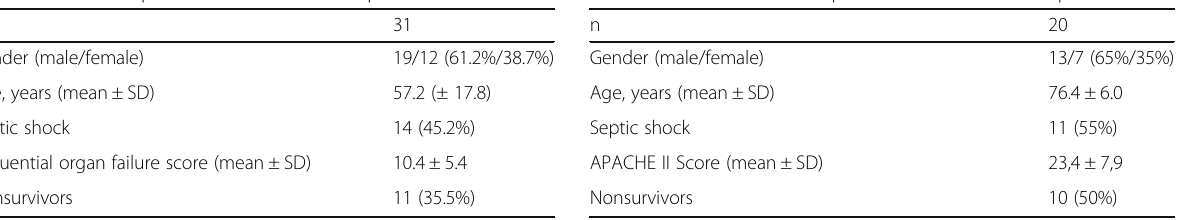
Table 2 T-cell samples: Characteristics of Sepsis Patients